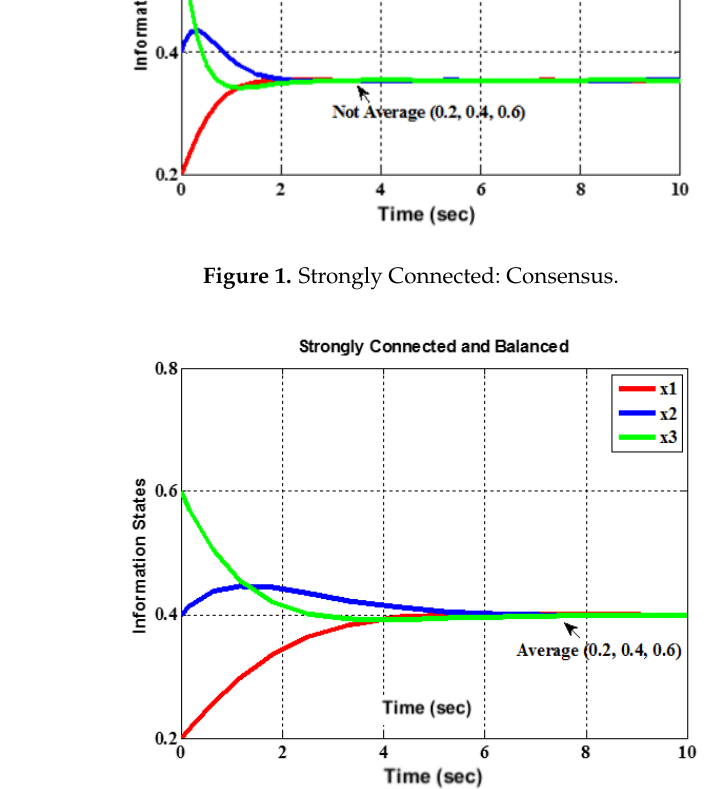
Figure 2. Strongly Connected and Balanced: Average Consensus.